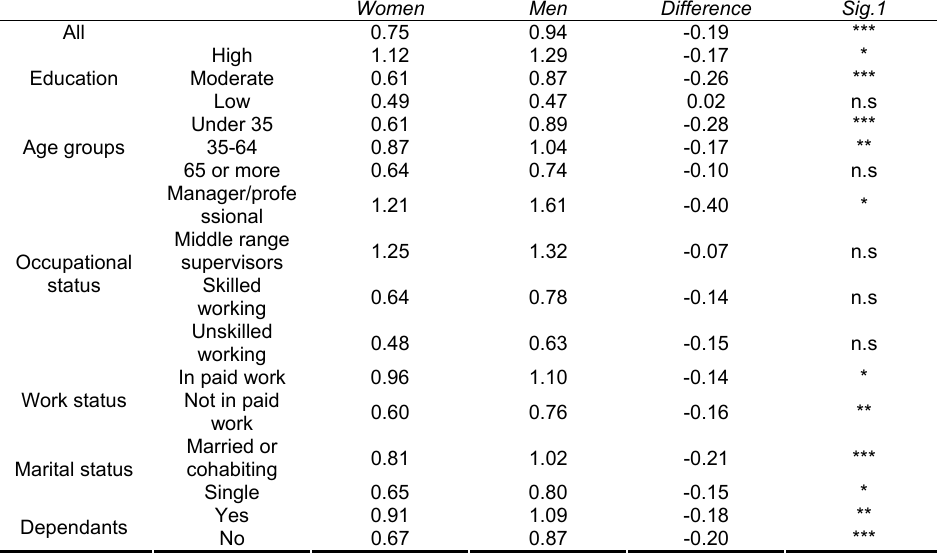
Table 6. Mean of organisational membership according to gender and control